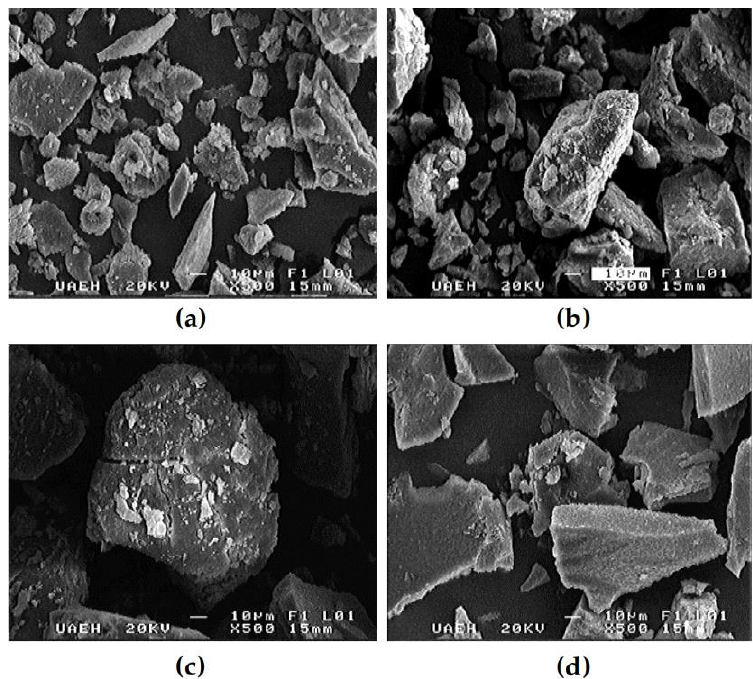
Figure 1. SEM micrograph of pacaya protein isolate ( a ) extracted from pacaya without thermal treatment; ( b ) extracted from pacaya under hydrothermal processing; ( c ) extracted from pacaya via steaming at an elevated temperature; ( d ) extracted from pacaya under microwave treatment.